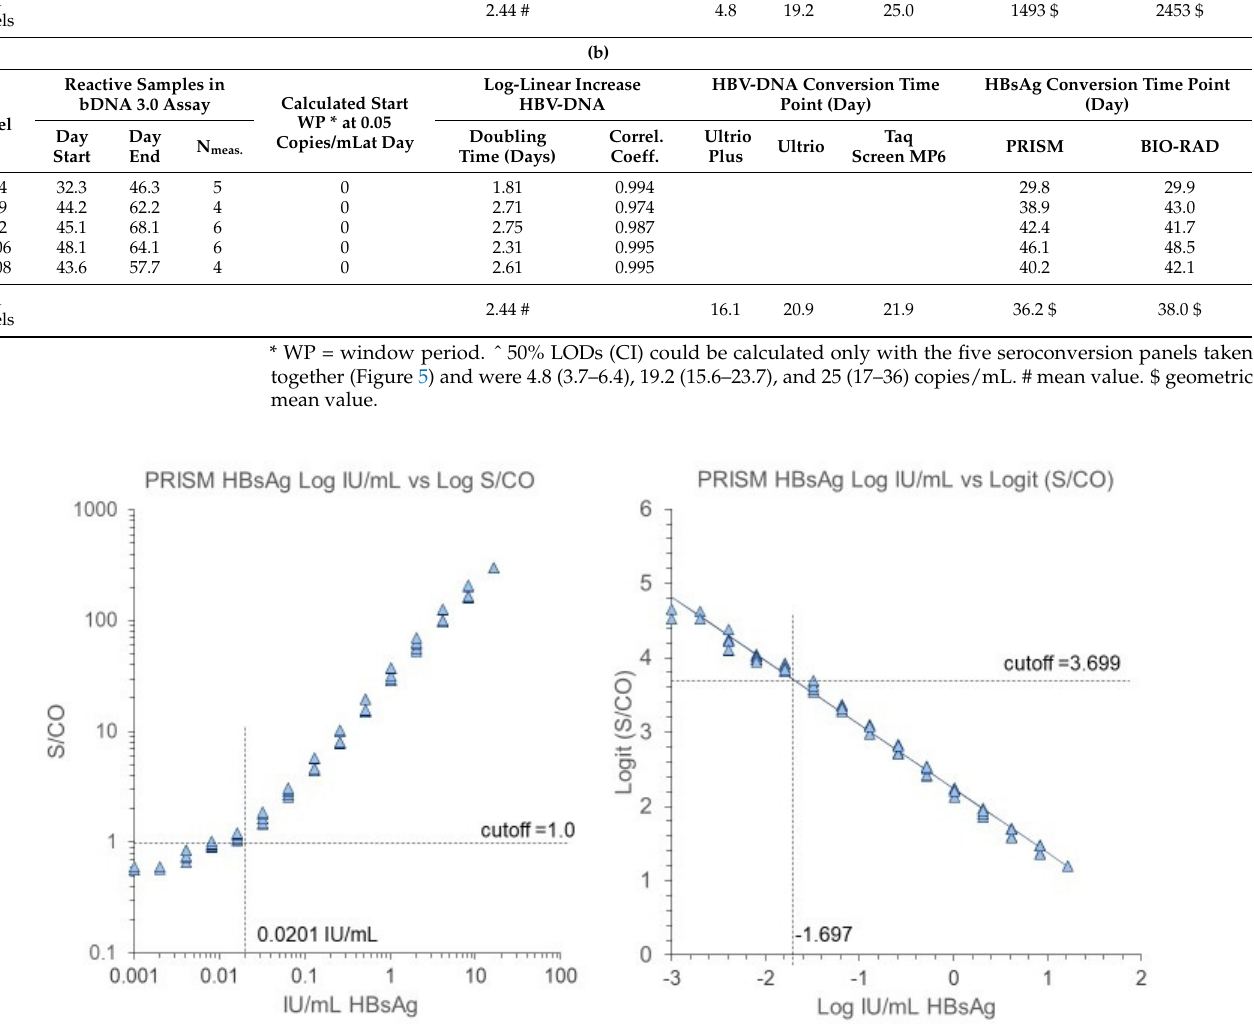
Figure 2. Example of course of Log HBV ‐ DNA concentration (copies/mL in bDNA 3.0 assay) and Log HBsAg concentration (mIU/mL in BIO ‐ RAD assay) in ramp ‐ up phase of viremia (seroconver ‐ sion panel #11006).